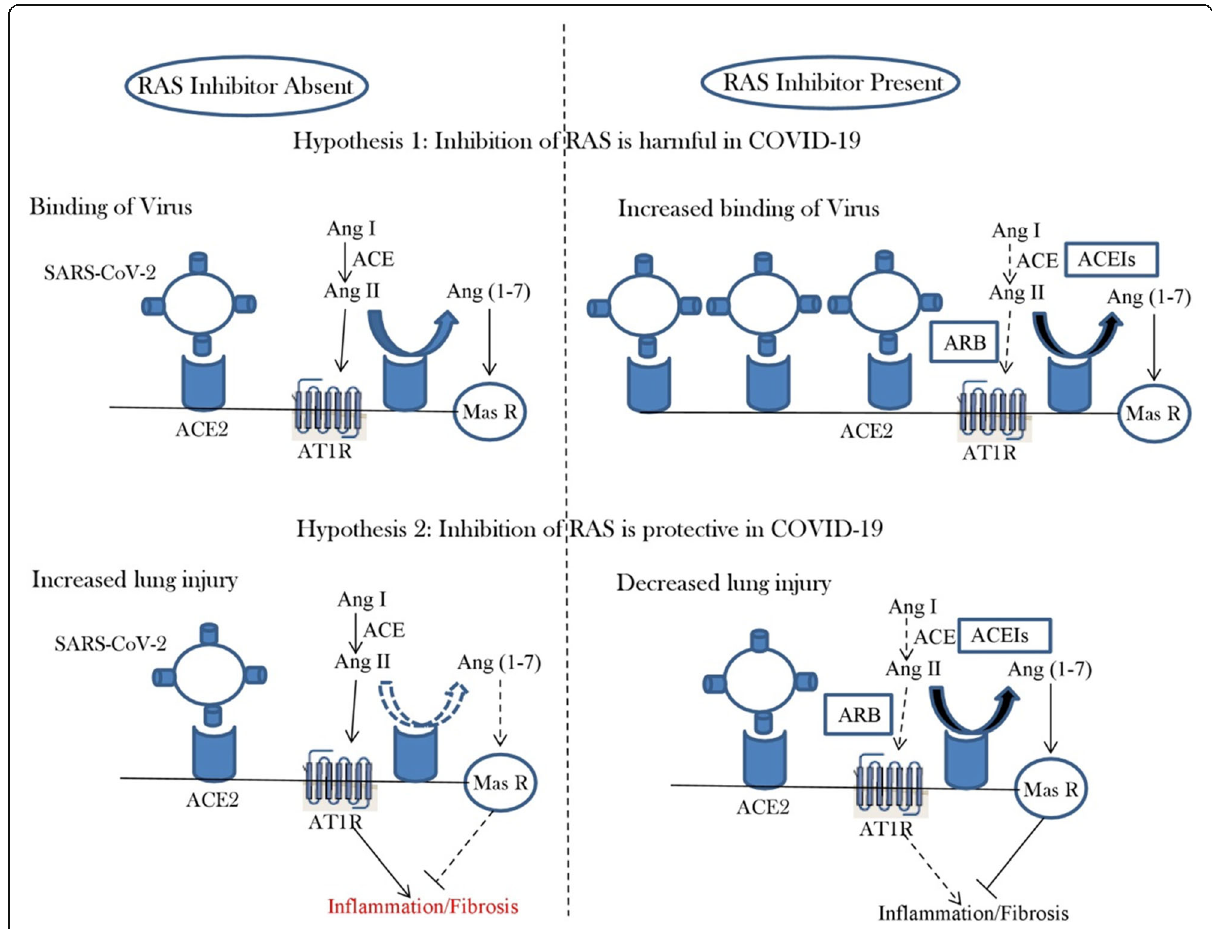
Fig. 1 Possible relation between renin-angiotensin system inhibition and COVID-19 [adapted from 19]. Competing hypothetical mechanisms by which use of ACEIs and ARBs might be harmful or protective in COVID-19. Hypothesis 1: SARS-CoV-2 enters cell by binding to ACE2. Use of ACEIs and ARBs could increase ACE2 abundance and enhance viral entry. Hypothesis 2: Ang II causes lung injury through inflammation and fibrosis upon activation of AT1R. Reduced production of Ang II by ACEIs or blockade of Ang II-AT1R interaction by ARBs increases generation of Ang (1-7) by ACE2 and activates Mas receptor (MasR) causing reduction in inflammation and fibrosis and thereby attenuating lung